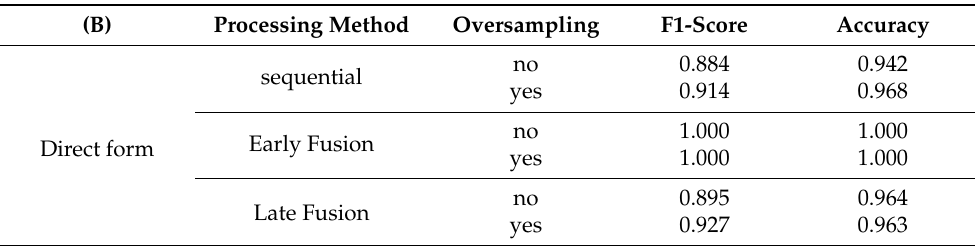
Table 2. F1-scores for module form and direct form for different processing methods, with and without oversampling for classification on validation